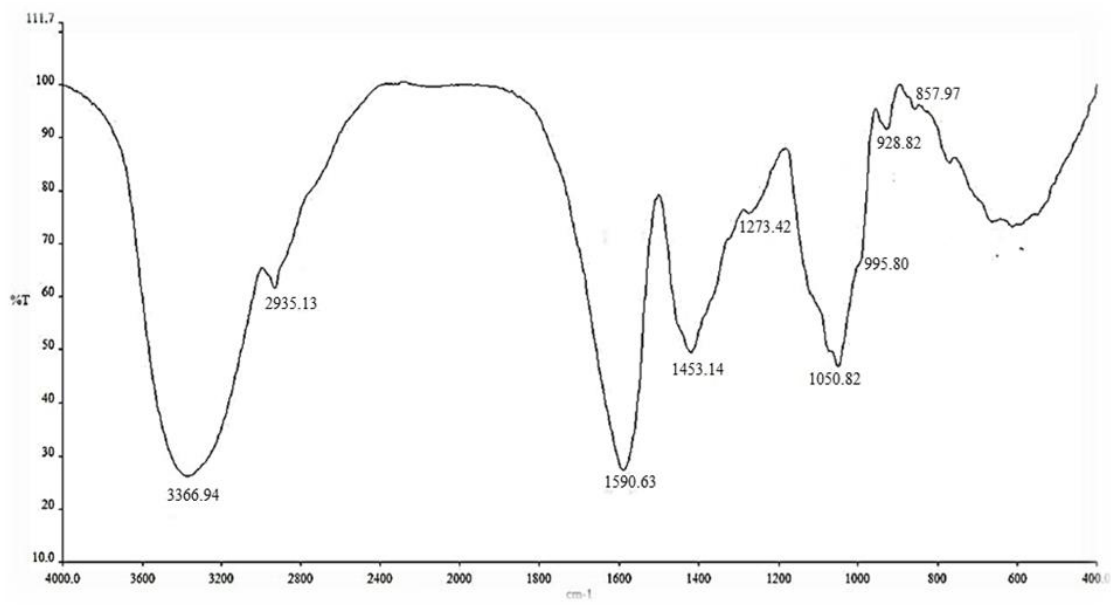
Figure 2. FTIR spectra (in KBr) of the purified Japanese (P-JP) pumpkin polysaccharide.